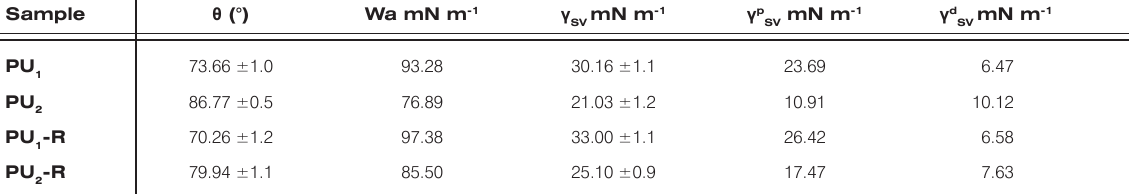
Figure 3. Water uptake of PU Table 3. Water contact angle, work of adhesion, surface free energy and polar and dispersive components of the surface free energy measurements.